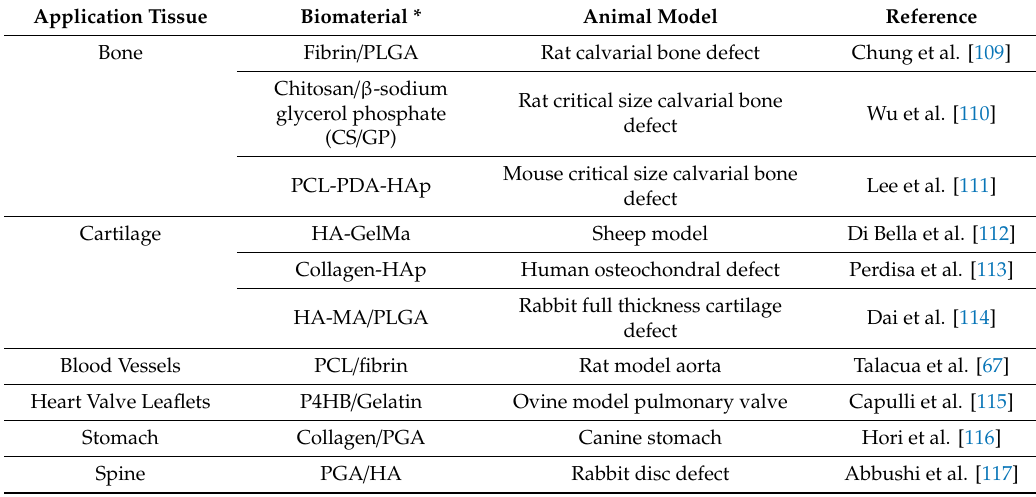
Table 3. Hybrid biomaterials used for in situ tissue